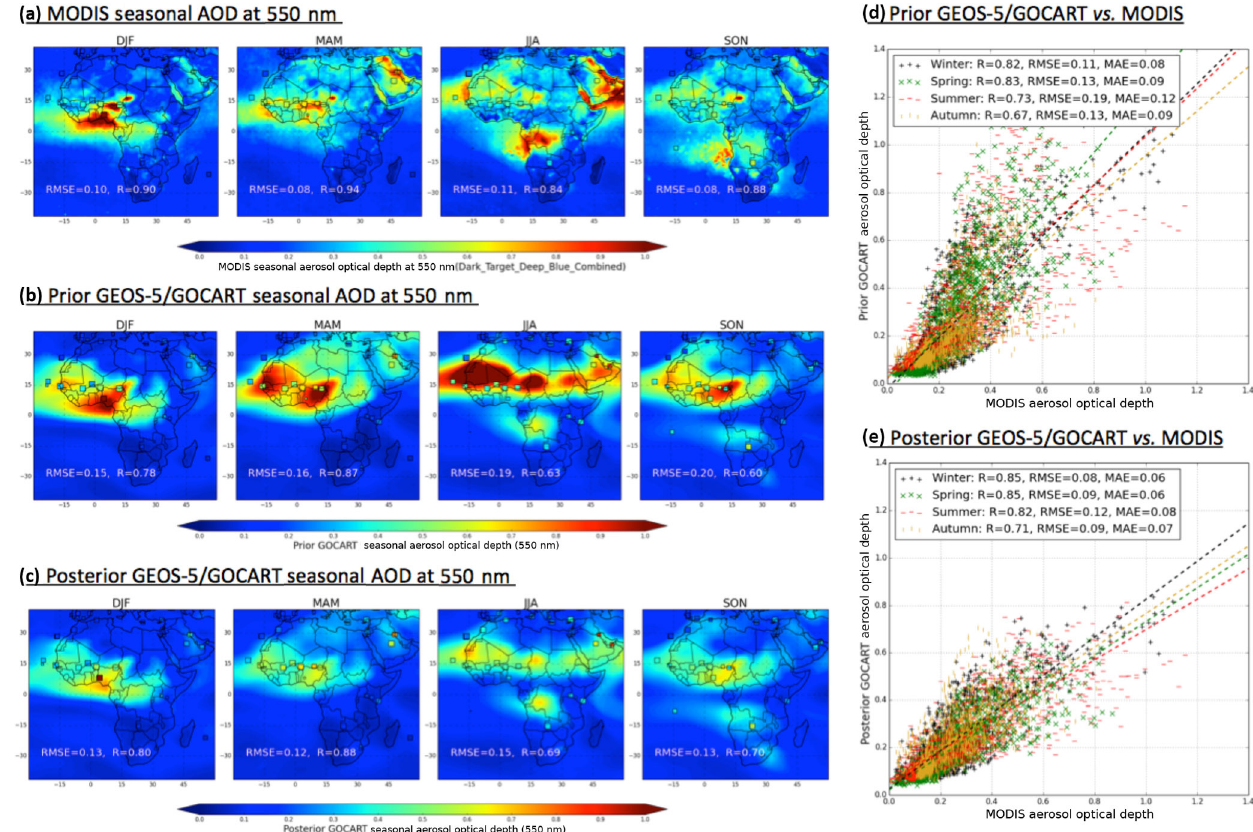
Figure 20. Comparison of the seasonal spatial distribution of prior (b) and posterior (c) GEOS-5/GOCART-simulated AOD at 550nm with MODIS observations (a) . The scatter plots of grid-to-grid comparison between MODIS and prior GEOS-5/GOCART AOD (d) and posterior GEOS-5/GOCART AOD (e) are also shown. The ground-based measurements from AERONET (squares) are over-plotted over panels (a) – (c) . The MODIS and GEOS-5/GOCART versus AERONET correlation coefficient ( R ) and root-mean-square error (RMSE) are provided in panels (a) – (c) . Meanwhile, the GEOS-5/GOCART versus MODIS R, RMSE and MAE are also provided in panels (d) – (e)